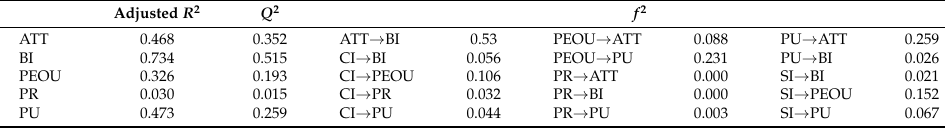
Table 7. Values of R 2 , Q 2 , and f 2